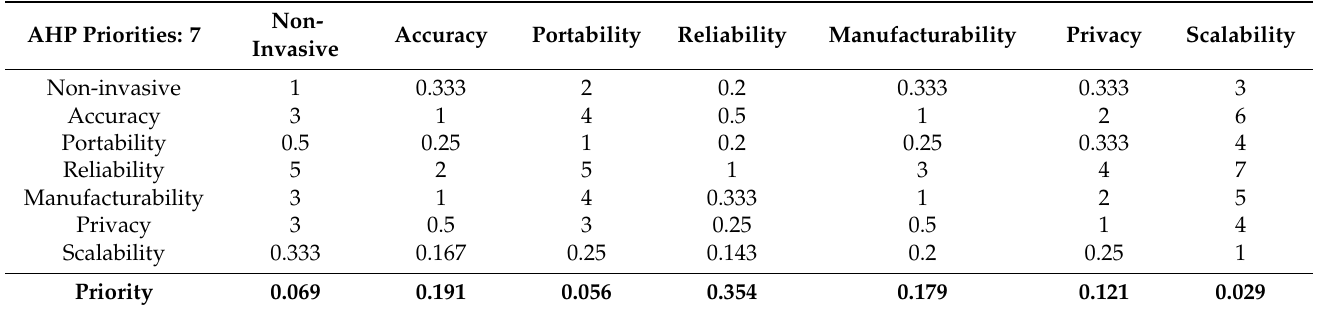
Table 1. AHP analysis for the criteria used in the selection detection